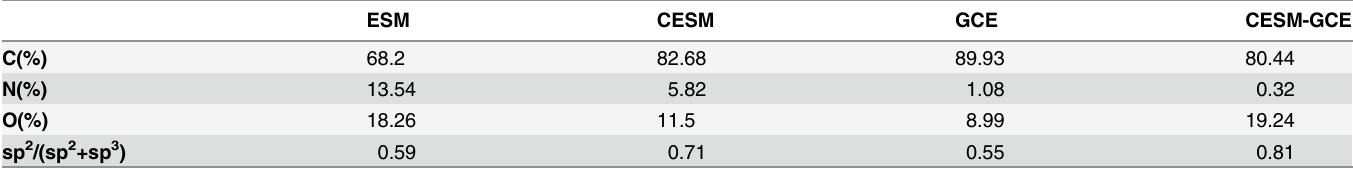
Table 1. Elemental composition determined from the wide-scan survey XPS spectra, and sp 2 /(sp 2 +sp 3 ) of C1s spectra for ESM, CESM, GCE, and CESM-GCE.